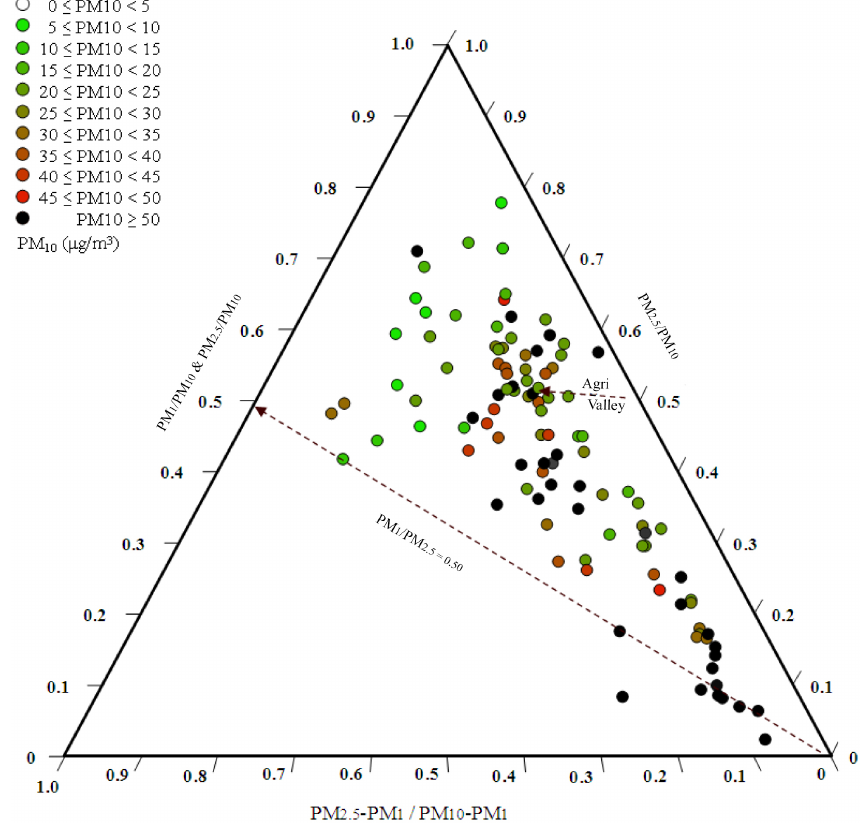
Figure 3. The triangular diagram of PM concentration ratios further categorized according to the PM 10 concentrations. The line in the center of the triangular diagram represents a PM 1 / PM 2 . 5 concentration ratio of